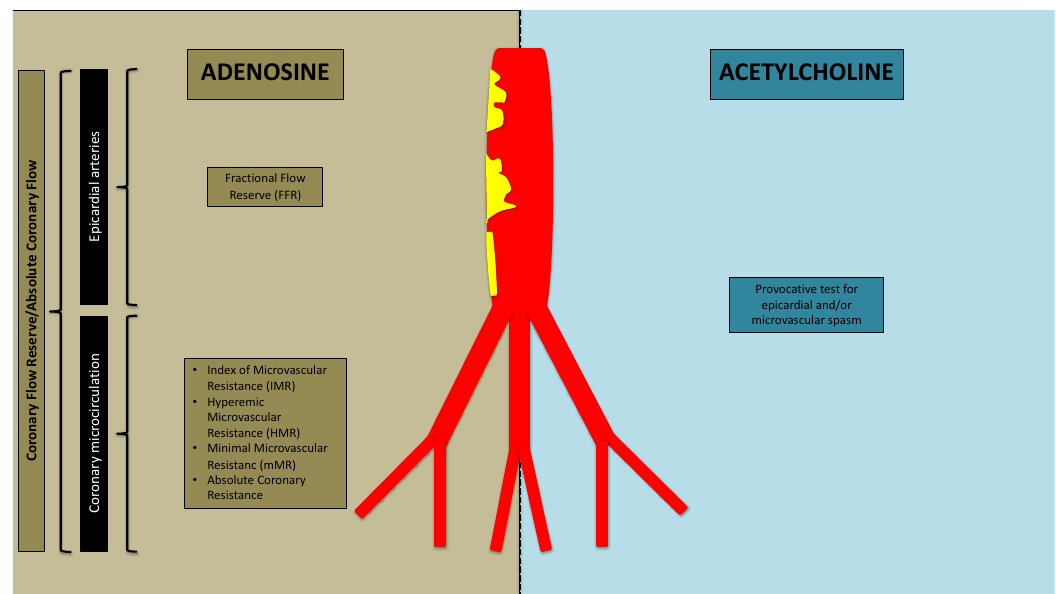
Figure 1. Invasive assessment of coronary circulation. Table 3. Invasive methods of coronary microvascular function assessment.